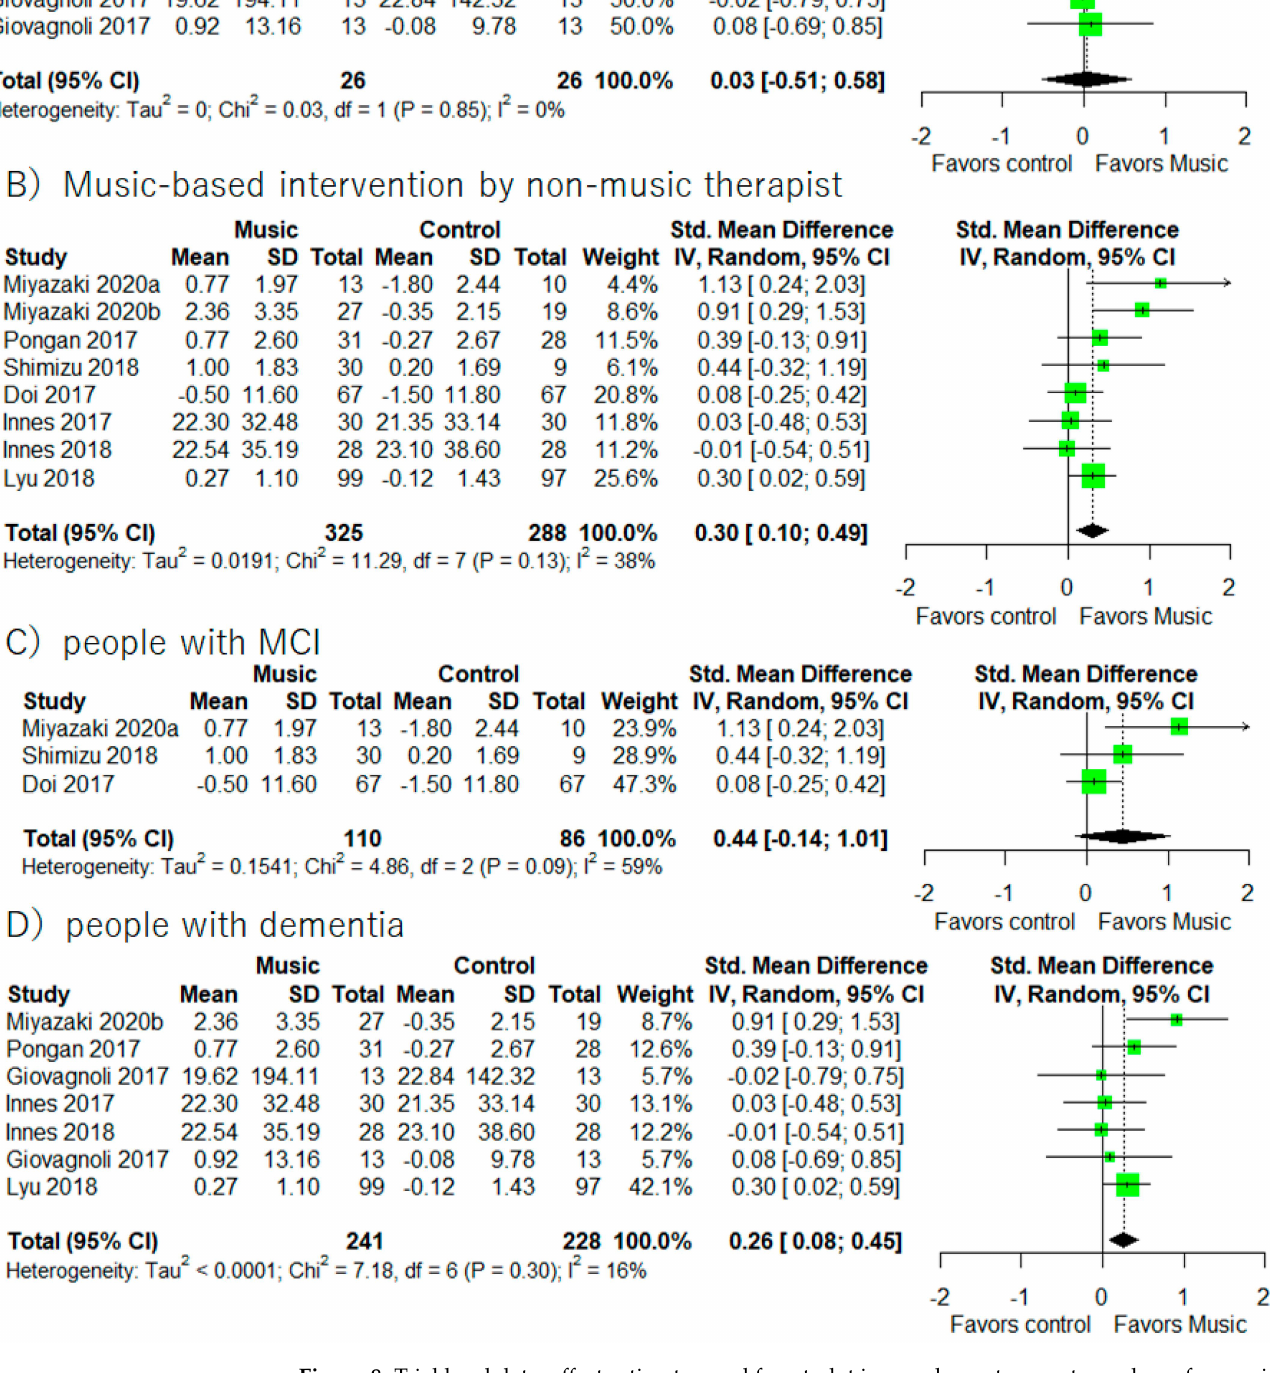
Figure 8. Trial level data, effect estimates, and forest plot in supplementary meta-analyses for music- based intervention by music therapist ( A ), music-based intervention by non-music therapist ( B ), people with MCI ( C ), and people with dementia ( D ). The area of green square is proportional to the study’s weight in the